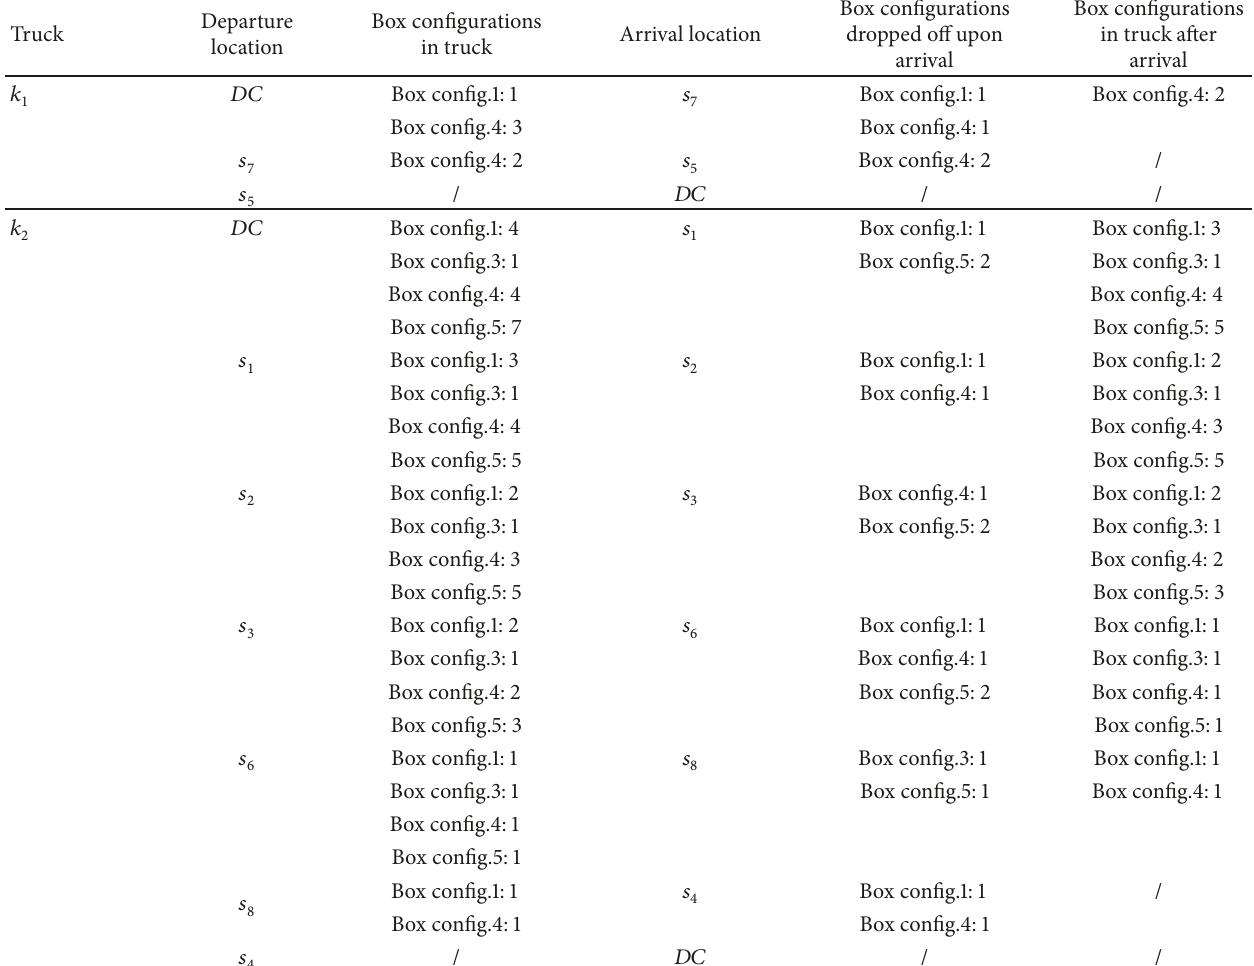
Table 7: Routing of collaborative shipping and changes of different box configurations in each